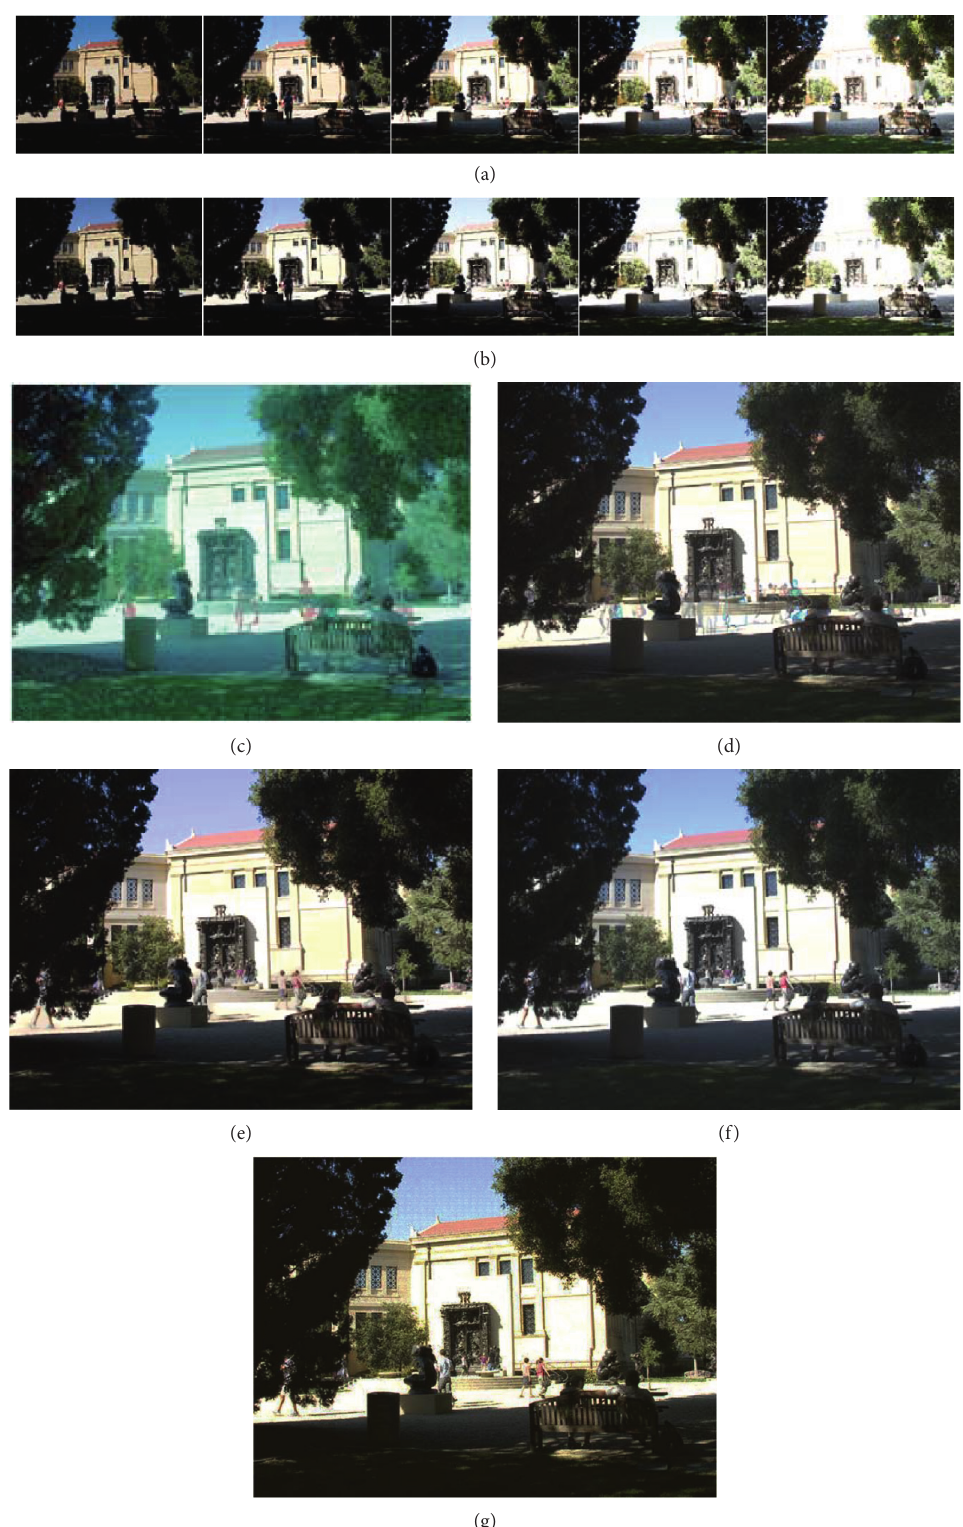
Figure 9: Multiple-exposure image sequences Sculpture Garden fusing result. (a) Multiple-exposure image sequence Sculpture Garden. (b) Sculpture Garden after compressive sensed and reconstructed. (c) Reference [31]. (d) Reference [2]. (e) SEN [25]. (f) HU [30]. (g)